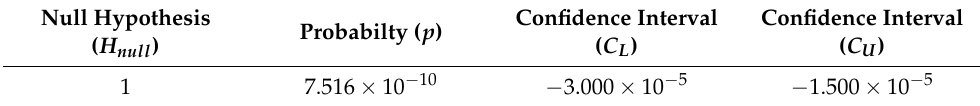
Table 4. Two-sample t -test on PCA features extracted from MammoWave’s complex S 21 data. Null Hypothesis Confidence Interval Confidence Probabilty ( p ) ( H null ) ( C L )